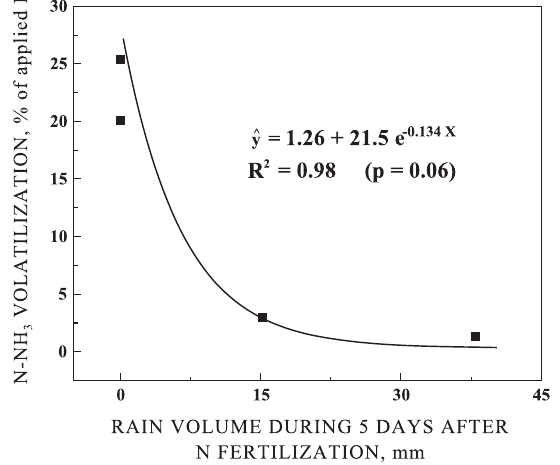
Figure 3. The relationship between the volume of rainfall in the five day period after superficial urea application and the cumulative ammonia volatilization in the 20 day period after N application (150 kg ha -1 ) in a no-till corn. Each data point refers to a harvest